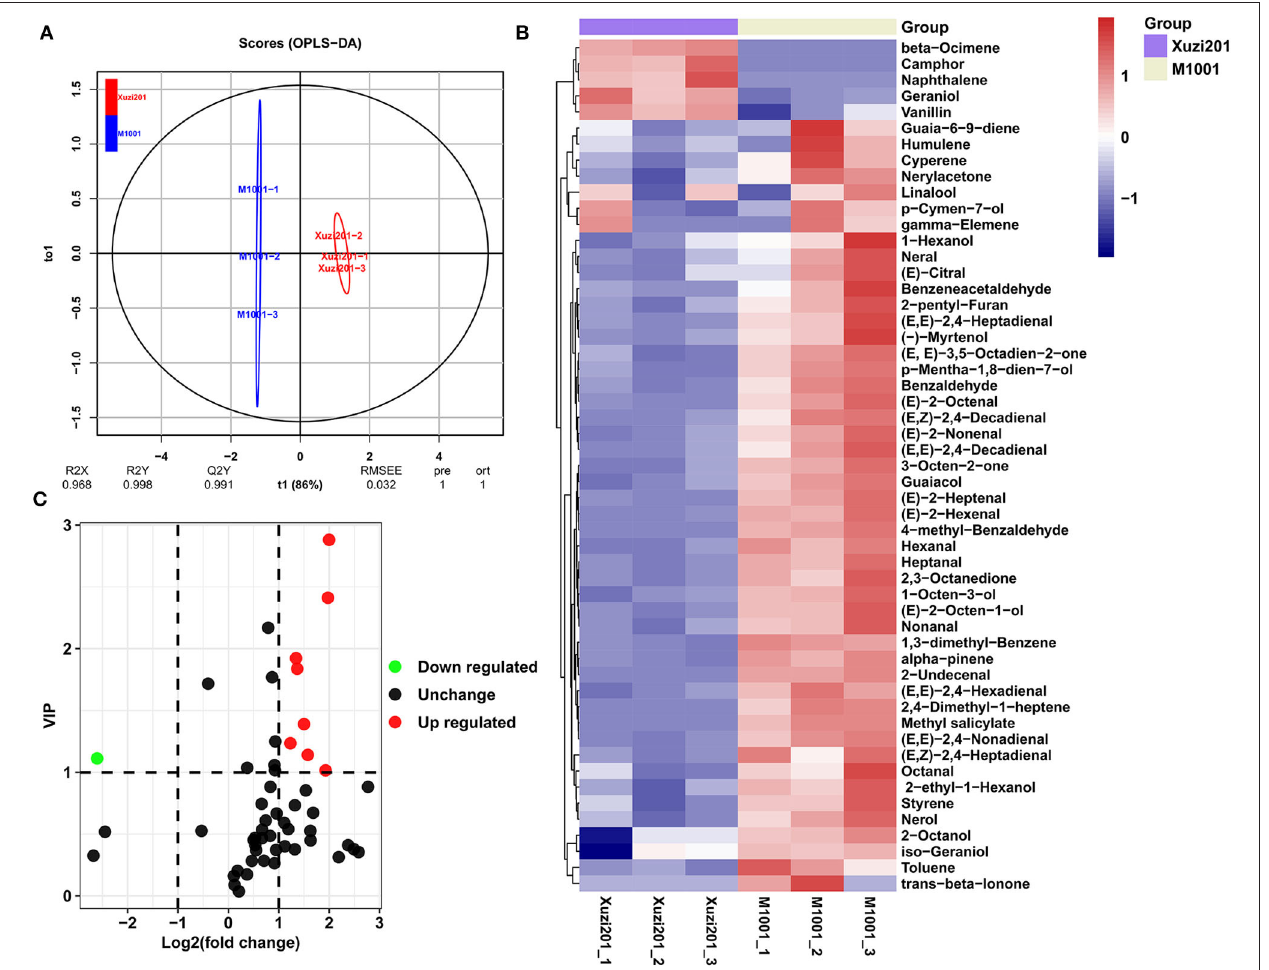
FIGURE 4 | Volatile metabolites analyses of tuberous roots of Xuzi201 and M1001. (A) OPLS-DA model plots and loading plots for the Xuzi201 vs. M1001. (B) Heatmap visualization of the relative differences in volatile metabolites in Xuzi201 and M1001. The content of each metabolite was normalized to complete linkage hierarchical clustering. Each example is visualized in a single column, and each metabolite is represented by a single row. Red indicates high abundance, whereas low relative metabolites are shown in blue. (C) Volcano plots displaying the upregulated, downregulated, and no regulated volatile metabolites between Xuzi201 and M1001. Horizontal coordinates are Log 2 FC of metabolites, and vertical coordinates are variable important in projection (VIP) values of metabolites. The red, green, and black dots represent upregulated, downregulated, and unchanged